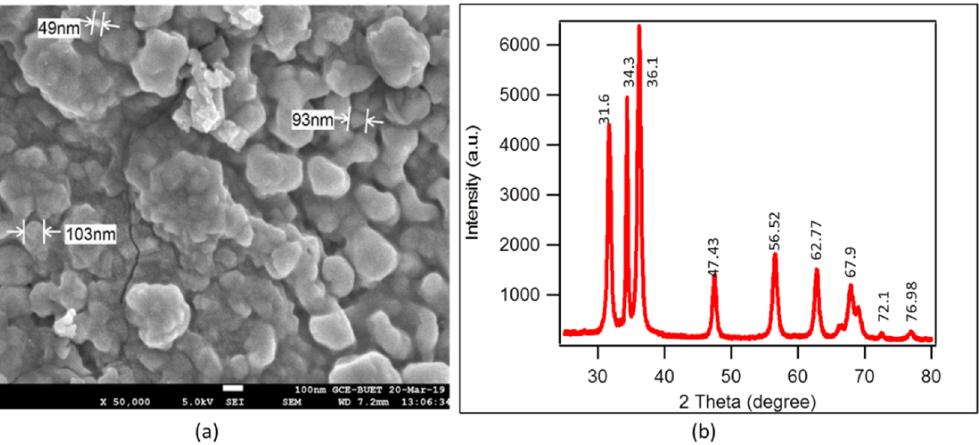
Figure 2. ( a ) SEM (scanning electron microscope) images of ZnO nanoparticles in ×50,000 magnifi- cation with size; ( b ) XRD (X-ray diffraction) pattern ZnO nanoparticles. (X-ray diffraction) pattern ZnO